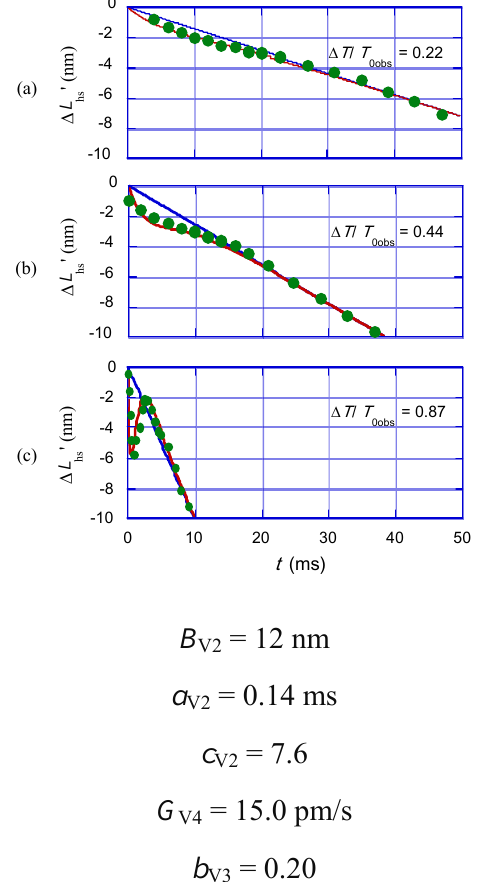
’ vs. time t for three values of  T / T hs